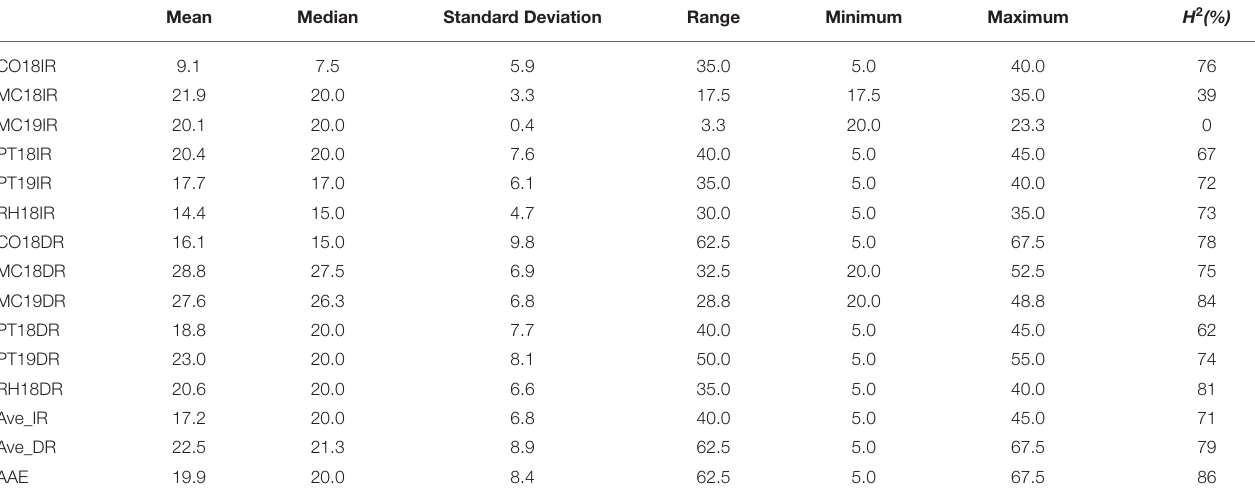
TABLE 1 | Descriptive statistics and broad-sense heritability ( H 2 ) of canopy wilting (CW) scores for 12 environments, Columbia (CO18), Maricopa (MC18 and 19), Pine Tree (PT18 and 19), Rohwer (RH18) under irrigated (IR) and drought (DR) treatments; averaged across irrigated (Ave_IR) and drought (Ave_DR) treatments; and averaged across all environments